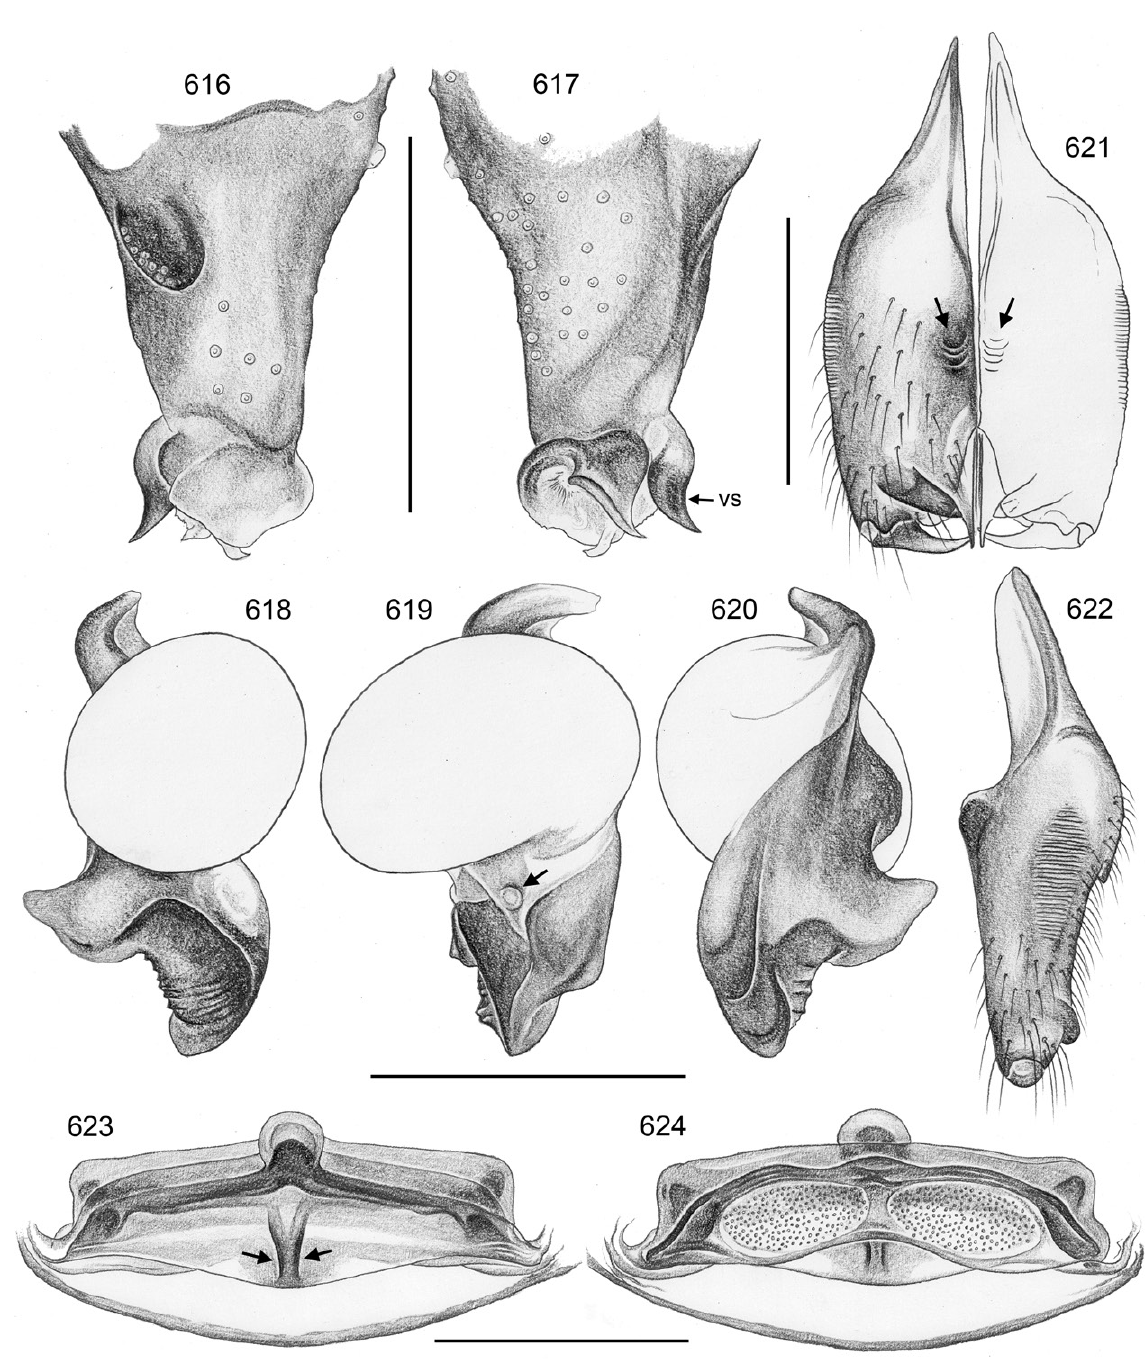
Figs 616–624. Crossopriza pristina (Simon, 1890); male from Eritrea, Massaua (MNHN Ar 10510), syntype female from Yemen, Aden (MNHN Ar 10511). 616–617 . Left procursus, prolateral and retrolateral views. 618–620 . Left genital bulb, prolateral, dorsal, and retrolateral views; arrow: sperm duct opening. 621–622 . Male chelicerae, frontal and lateral views; arrows: low sclerotized humps. 623– 624 . Cleared female genitalia, ventral and dorsal views; arrows: pockets. Abbreviation: vs = ventral sclerite. Scale bars = 0.5